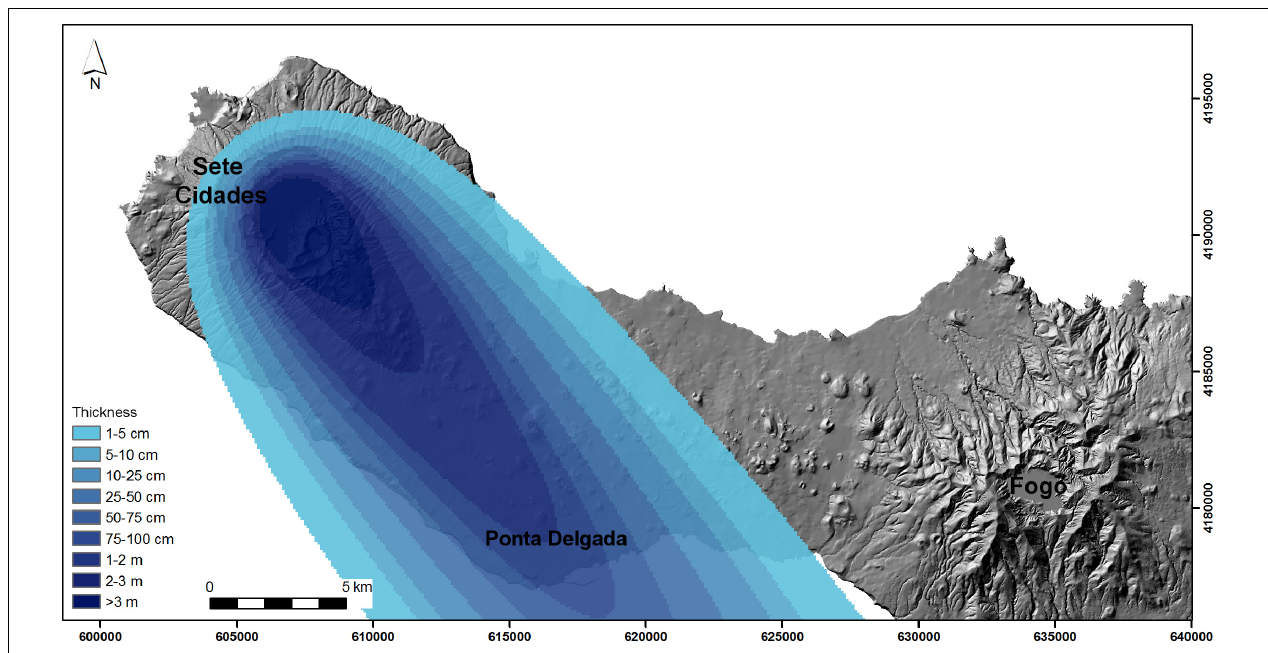
FIGURE 8 | Scenario 3 tephra fall map resulting from the simulations with VORIS 2.0.1, showing the potential impact of a future explosive eruption of Sete Cidades volcano, with the same eruptive source parameters obtained for scenario 2 and wind blowing from NW.